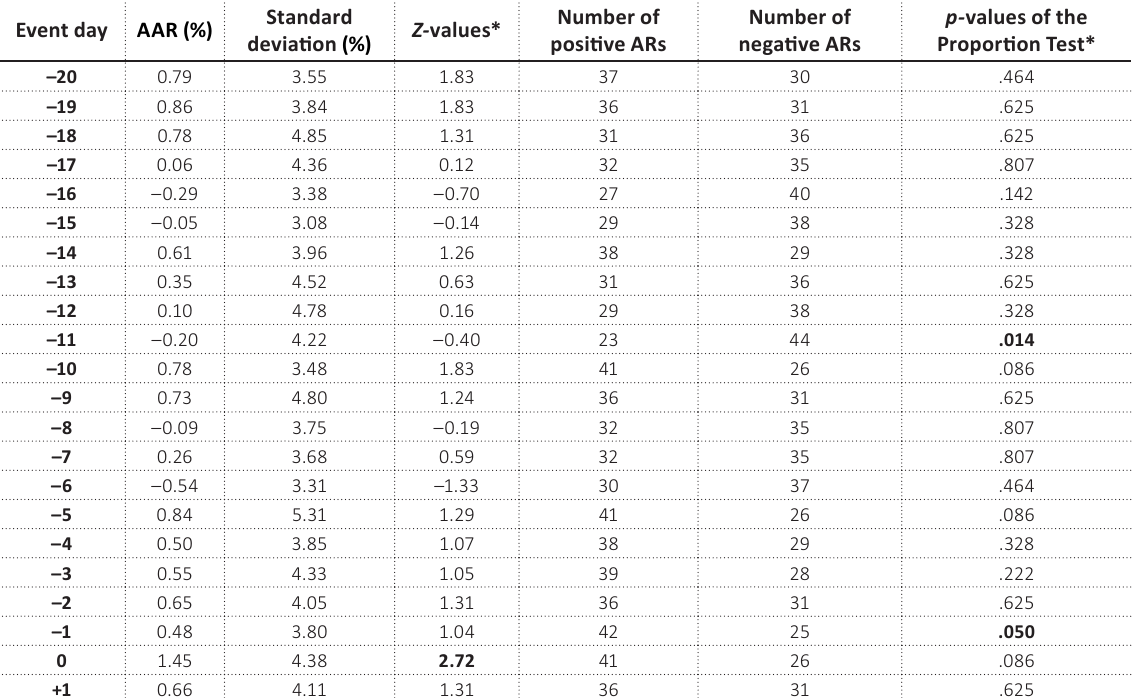
Table 3. AARs and Z -values – Announcement Day (split ratio